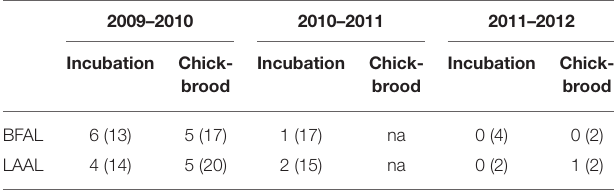
FIGURE 5 | A canonical analysis of principal components displays the functional groups of prey that have the strongest influence on dietary differences between Laysan and black-footed albatrosses during the incubation and chick-brood breeding phases. Because of differences in foraging grounds between the species, particularly during incubation, we further classified functional groups by sub-region, wherever applicable. Lengths and directions of arrows represent the strength and sign of the correlation of functional groups with the two canonical axes and asterisks(*) represent moderate significant correlations ( > 0.03). TABLE 3 | Incidence of fisheries exploitation in Hawaiian